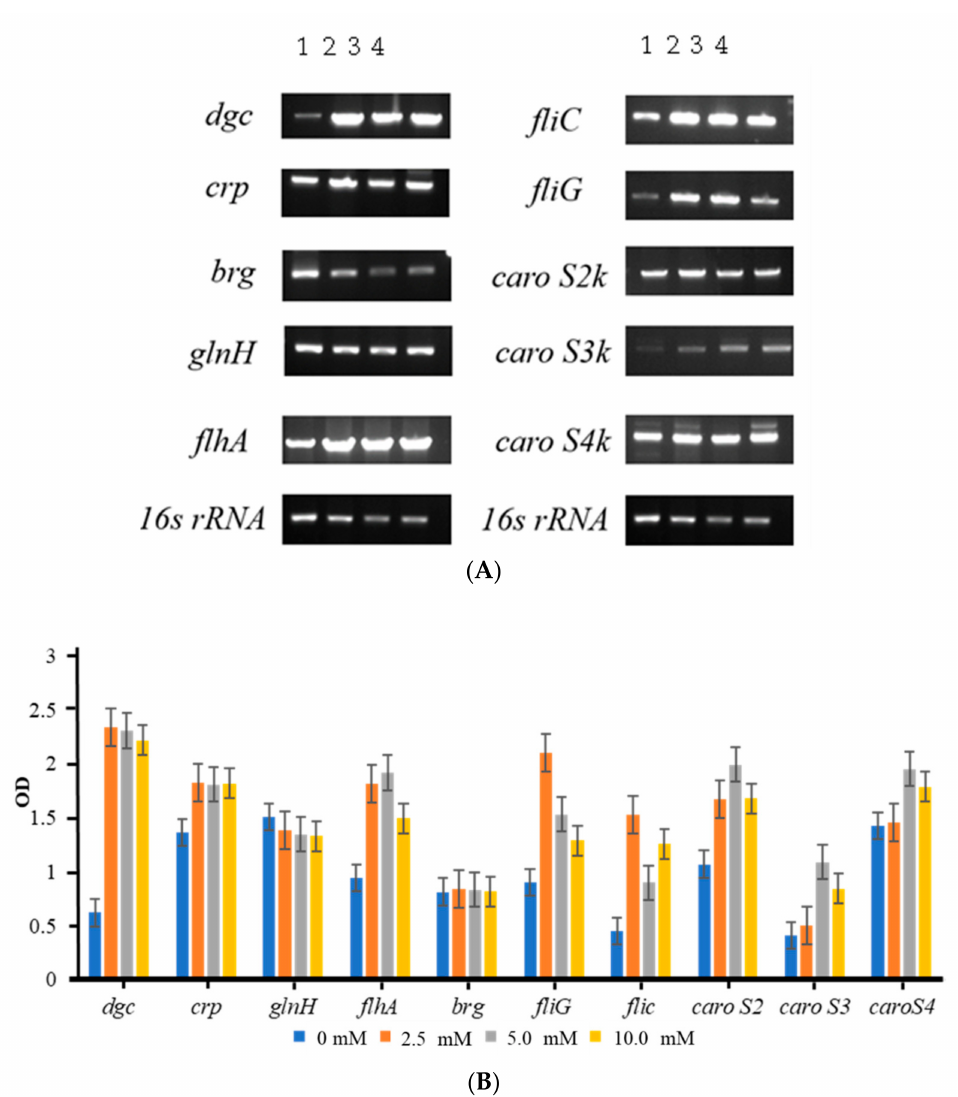
Figure 4. Transcriptional analysis of bacteriocin genes and regulatory genes by two-step endpoint RT-PCR induced with different concentrations of L-glutamine. ( A ) Gel electropherogram of RT-PCR products exhibited by the wild-type and the dgc knockout strain: 1, 0 mM; 2, 2.5 mM; 3, 5.0 mM; 4, 10 mM. ( B ) Mean relative gene expression affected by the L-glutamine